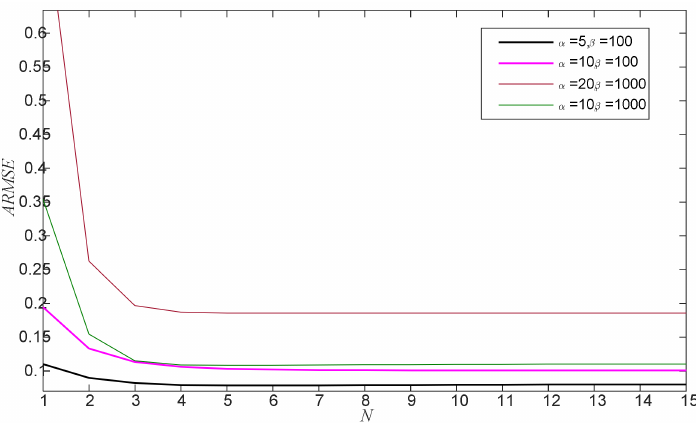
Figure 12. The ARMSE result of RSIKF with different N for the cases of α and β